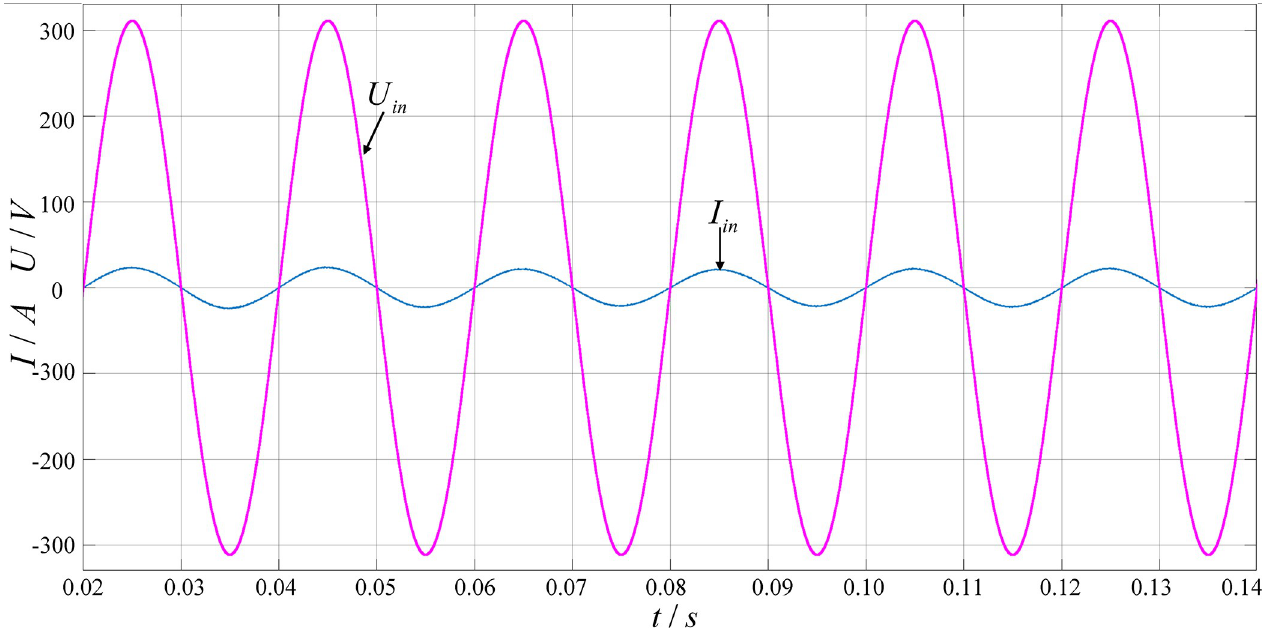
Fig 15. PFC input voltage and current waveform.